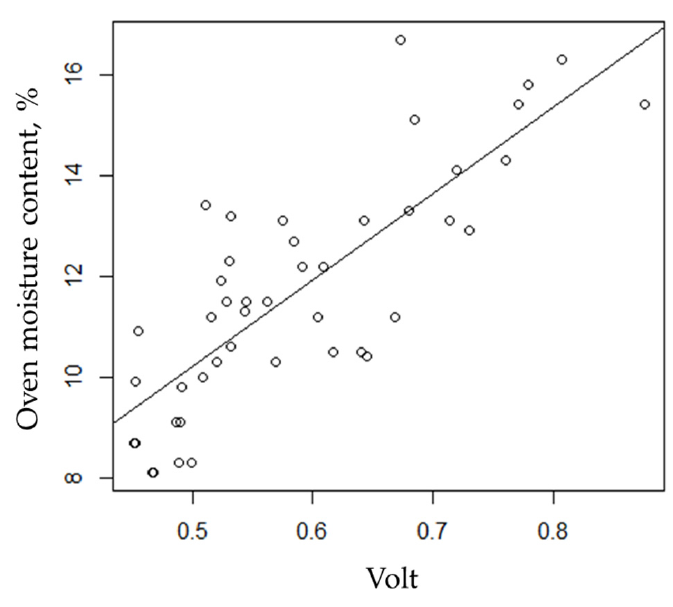
Figure 4. Linear regression of V and oven moisture (%). MC = 17.131V + 1.635, residual standard error: 1.366 at 43 degrees of freedom, multiple R 2 of 0.655, adjusted R 2 of 0.647, F-statistic of 81.79 on 1 and 43 DF; p -value of 1.663 × 10 − 11 .